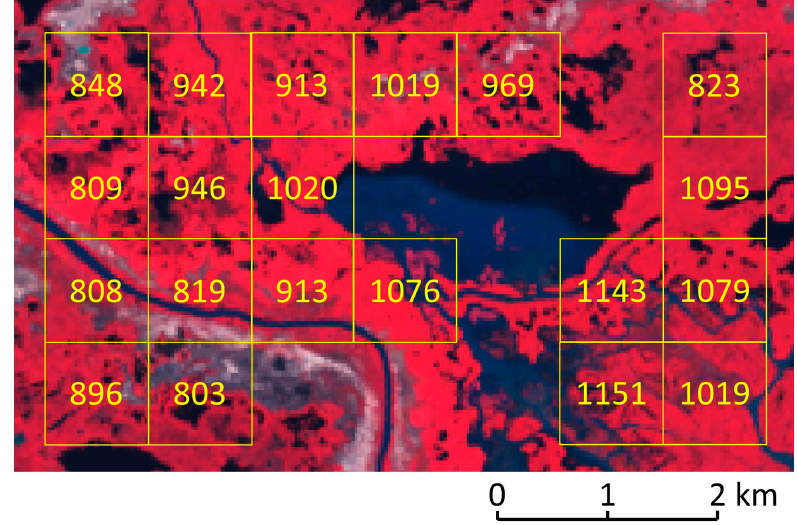
Figure 6. ET a of a representative wetland area in the Ili Delta over growing season 2014. Yellow boxes show pixels of the ET a map. Yellow numbers: ET a (mm) within the given pixel. These pixels belong to submerged dense reed. Background: The areas not covered by pixels are either open waters or vegetation other than reed. Landsat image (LC8, path 151, row 28) from 19 August 2013.